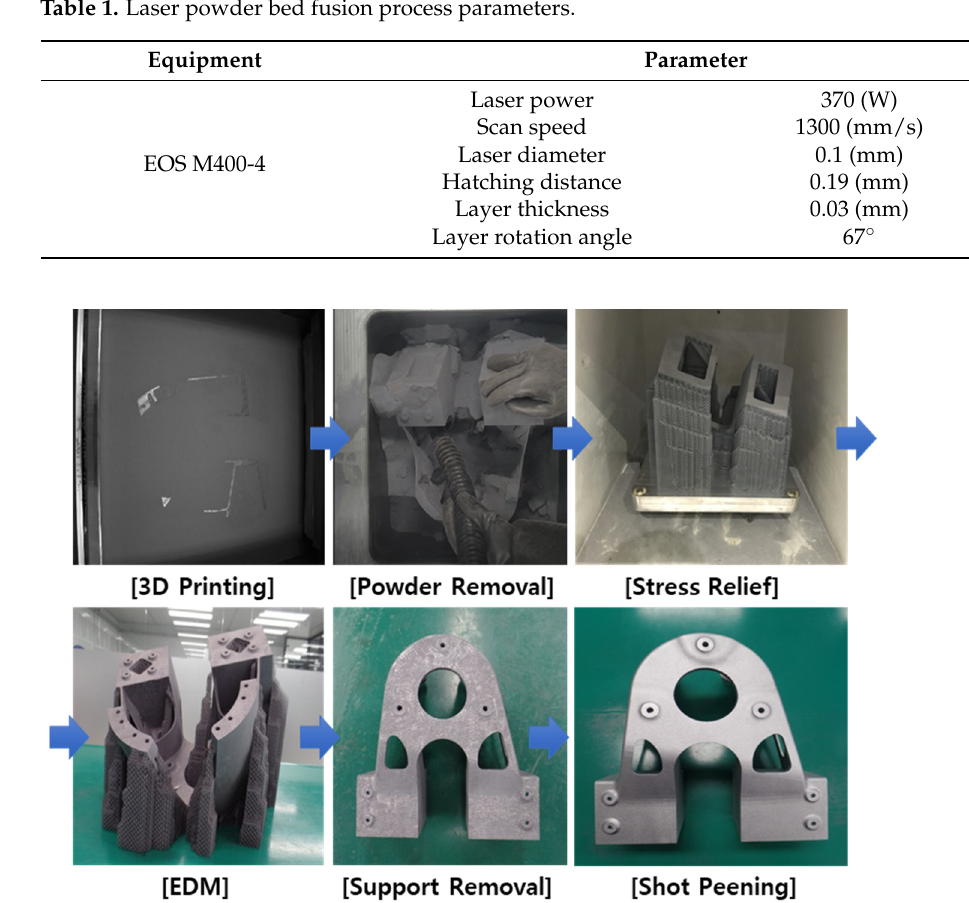
Figure 6. AM process of shock absorber mount node part.